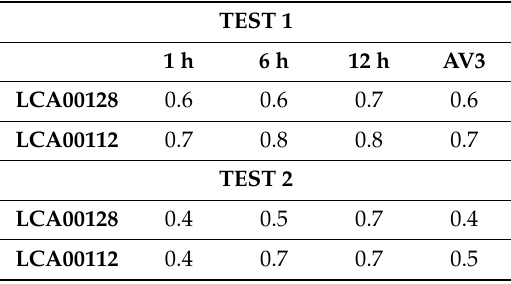
Figure 5. Trajectories simulated by the model for each release made on each position of the drifters LCA00128 ( a ) and LCA00112 ( b ) paths. In black is the trajectory of each drifter, and in green the path of the particles at their first release. In gray is the groups of particles released at each hourly position. Table 2. Skill score of the results of the numerical simulations performed in the two calibration tests (Test 1 and Test 2) calculated at the forecast intervals of 1, 6, and 12 h from the release and AV3 for each single trajectory (LCA00128 and